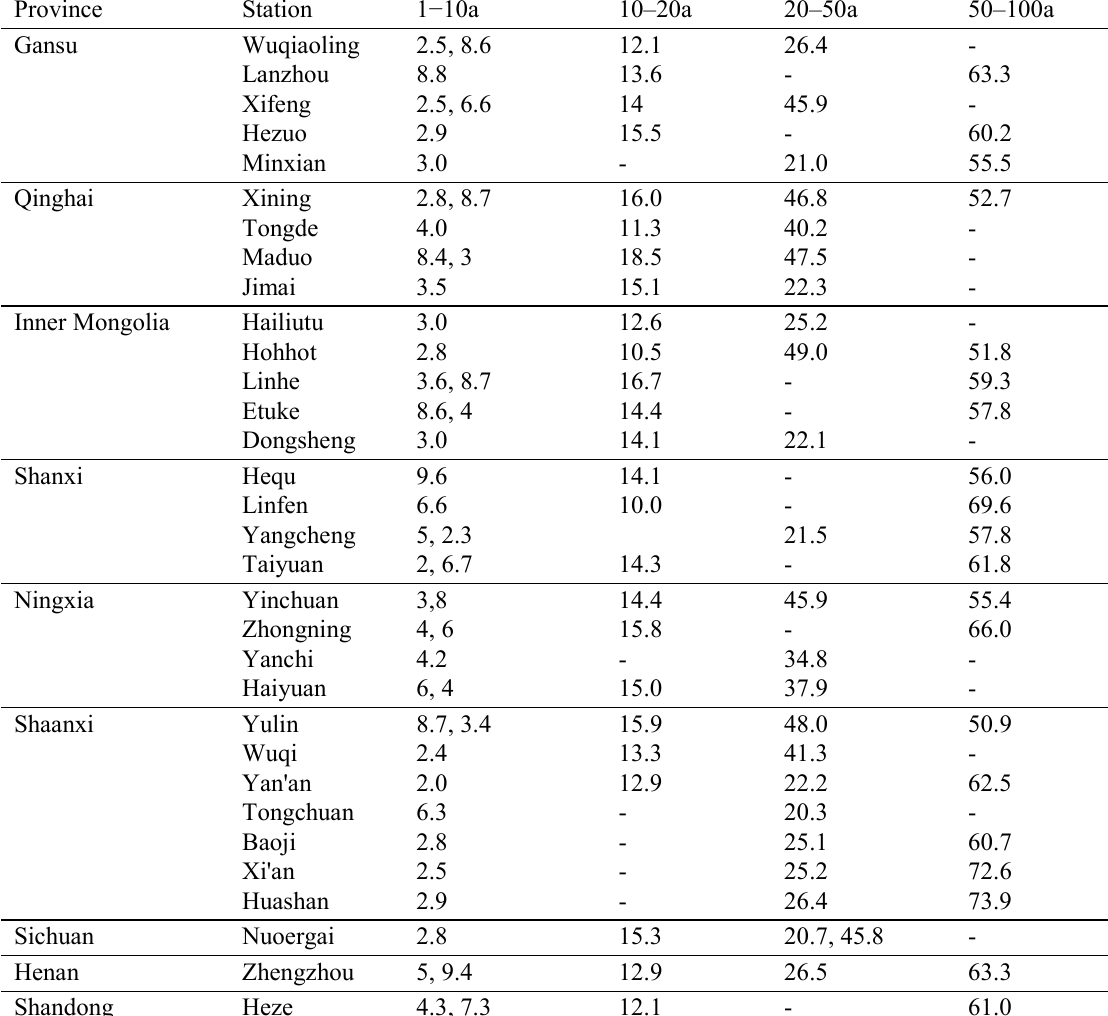
Table 1 Precipitation cycles of stations on different scales in the Yellow River basin (unit a).